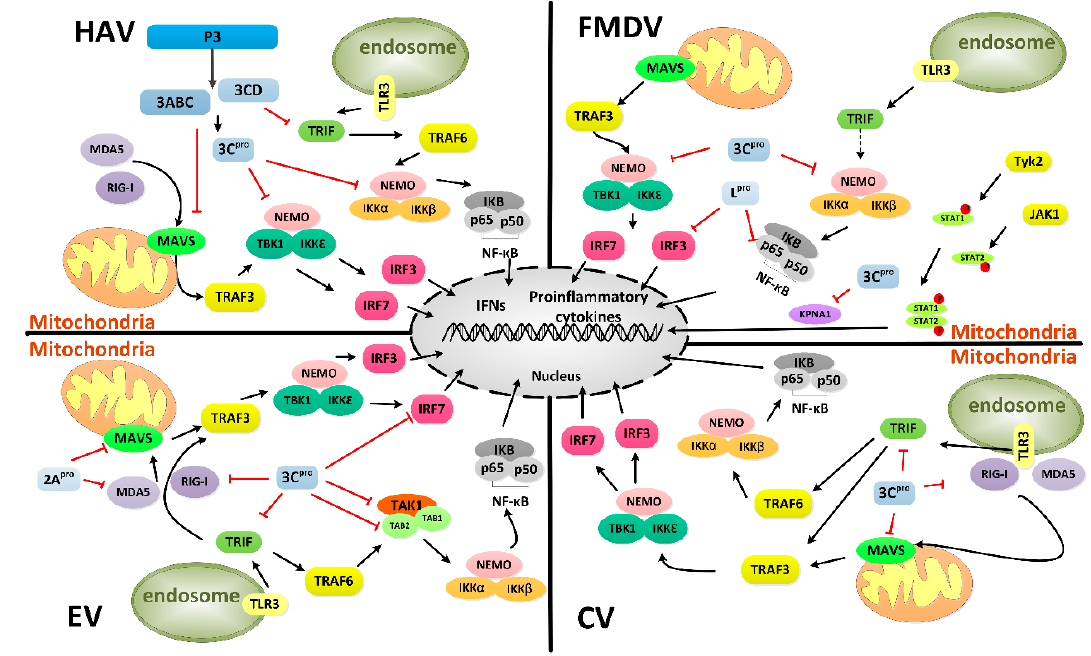
Figure 6. Mechanisms of 3C pro from different picornaviruses suppress the immune response. It has been demonstrated that 3C pro interferes with the host type I interferon (IFN) response and nuclear transcription factor kappa B (NF- κ B) signaling pathway by cleaving several essential proteins. However, the mechanisms adopted by picornaviruses are slightly different. The immune response is depicted in black. Inhibition of immune response by viral proteinases is highlighted in red. Abbreviations